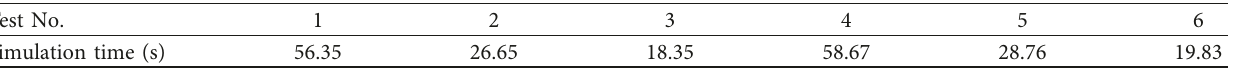
Table 7: Simulation times for the circular path entering cases